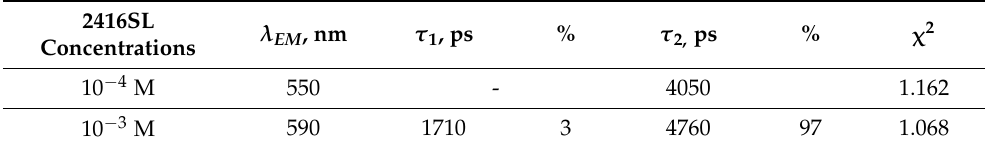
Table 3. PL lifetimes of aqueous solutions of 2416SL for various concentrations and λ EM ; λ e = 405 nm; T = 296